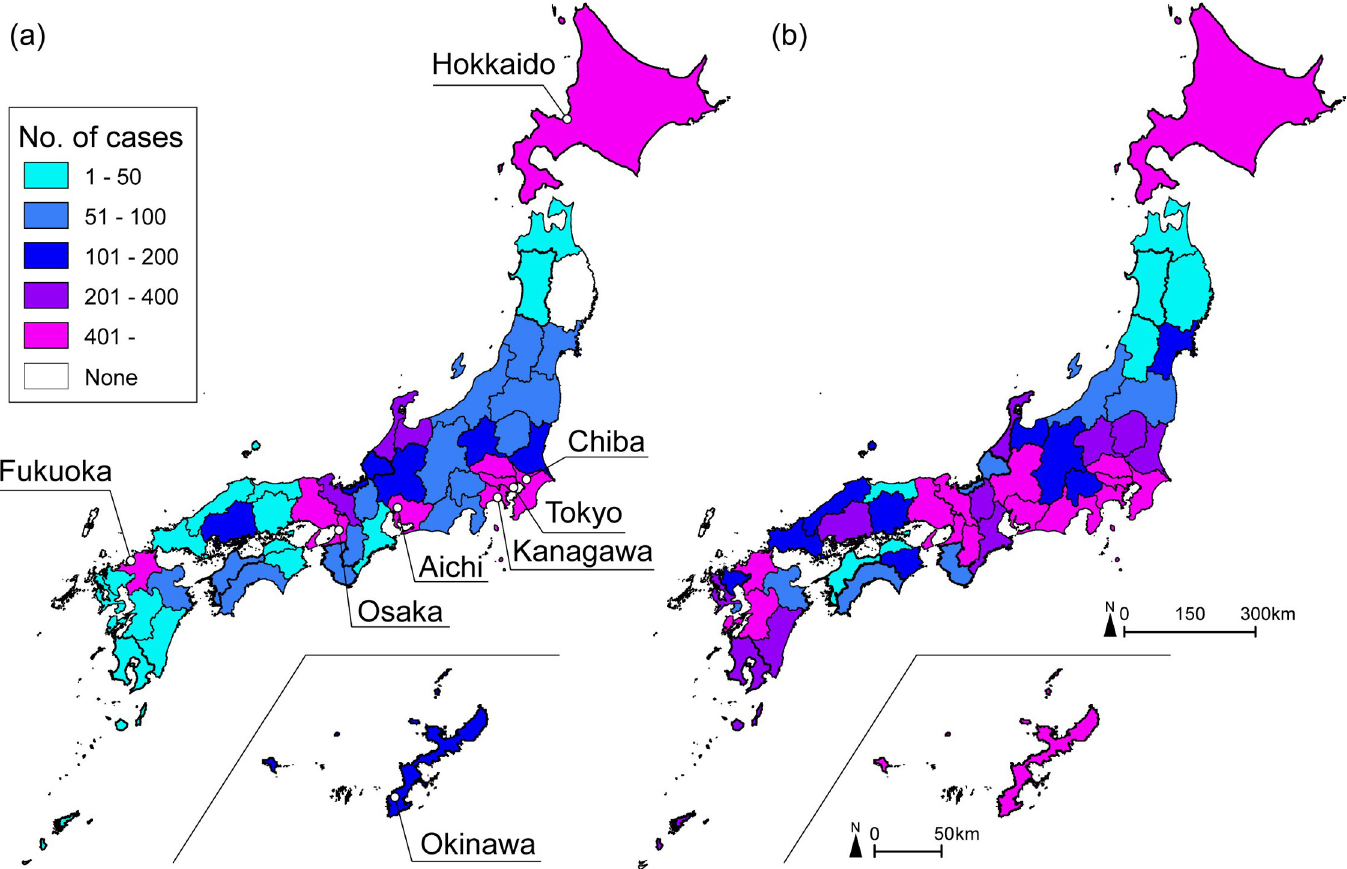
Fig 1. No. of cases in 1 st epidemic wave and 2 nd epidemic wave. (a) No. of cases at 1 st epidemic wave (January 16 to May 24). (b) No. of cases at 2 nd epidemic wave (May 25 to August 30). Total no. of cases in each prefecture is shown in S1 Table.